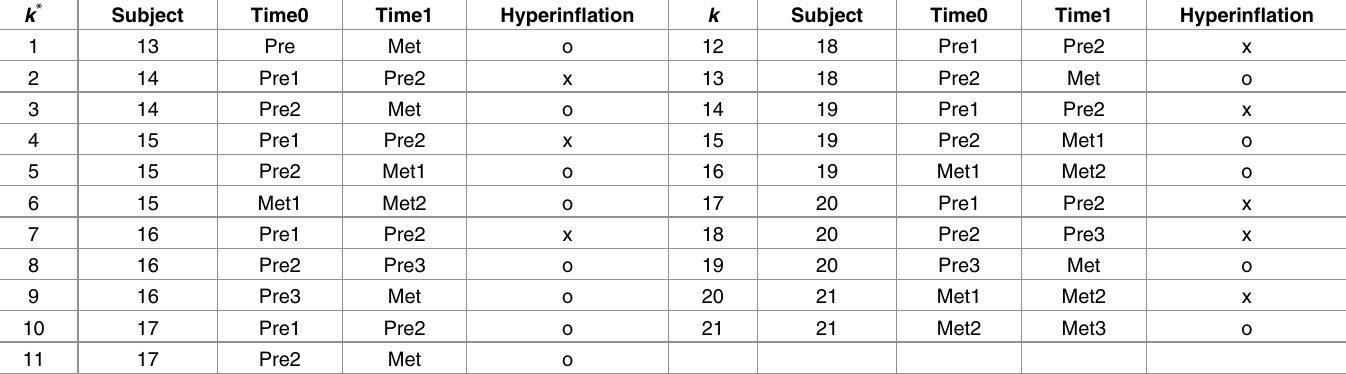
Table 4. Hyperinflation from visual inspection of sarcomasubject pairs with metastases.